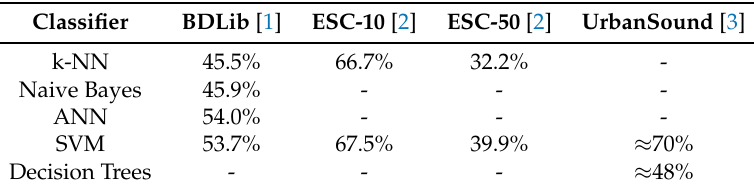
Table 3. Classifiers’ accuracy per dataset reported in the literature.